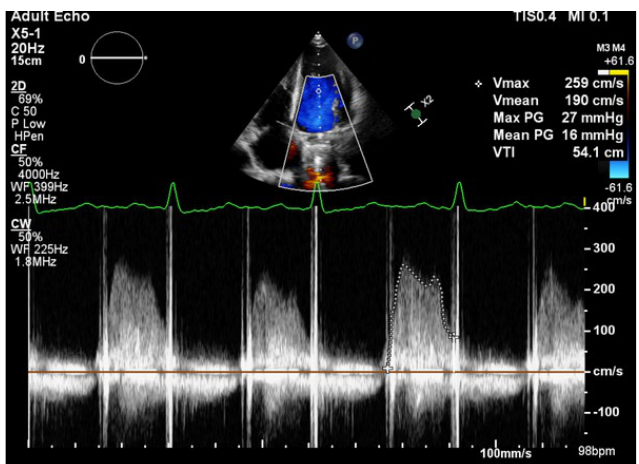
Figure 2. Transthoracic echocardiography: CW-Doppler of transmitral in- flow revealing severe functional mechanical mitral valve stenosis (dpmean 16mmHg; HR 98bpm; Hemoglobin 63g/l) Anemia persisted despite aggressive intravenous iron supplementation